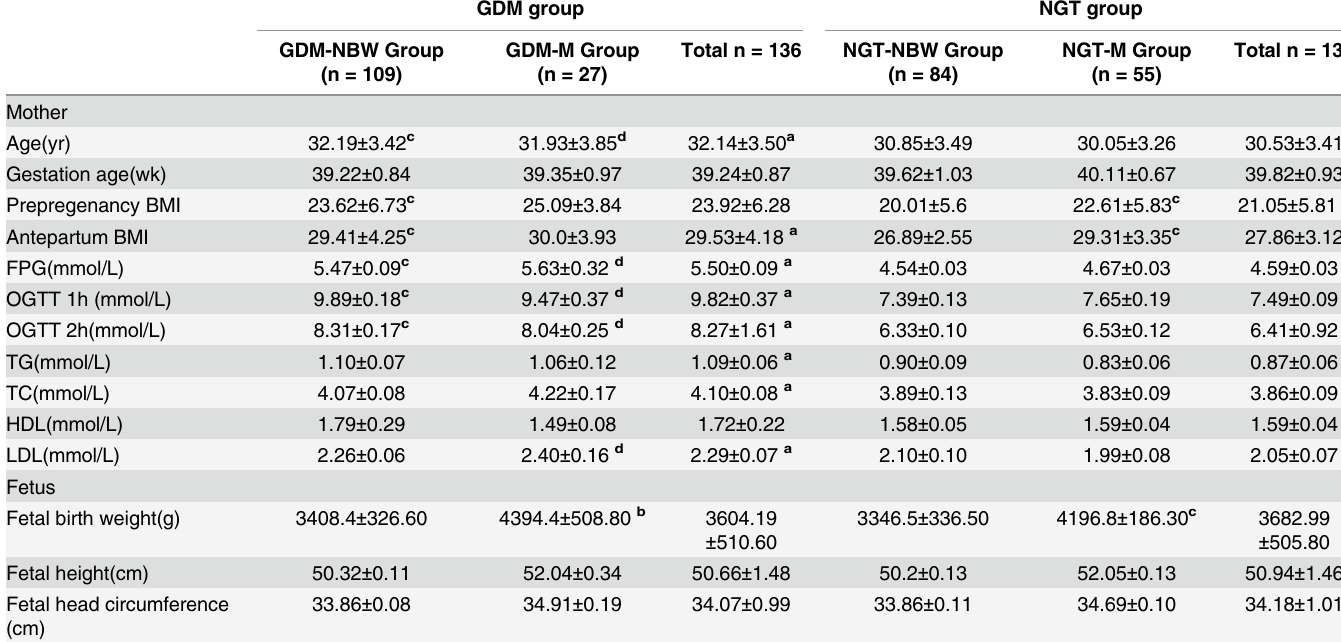
Table 1. Clinical Characteristics of the Study